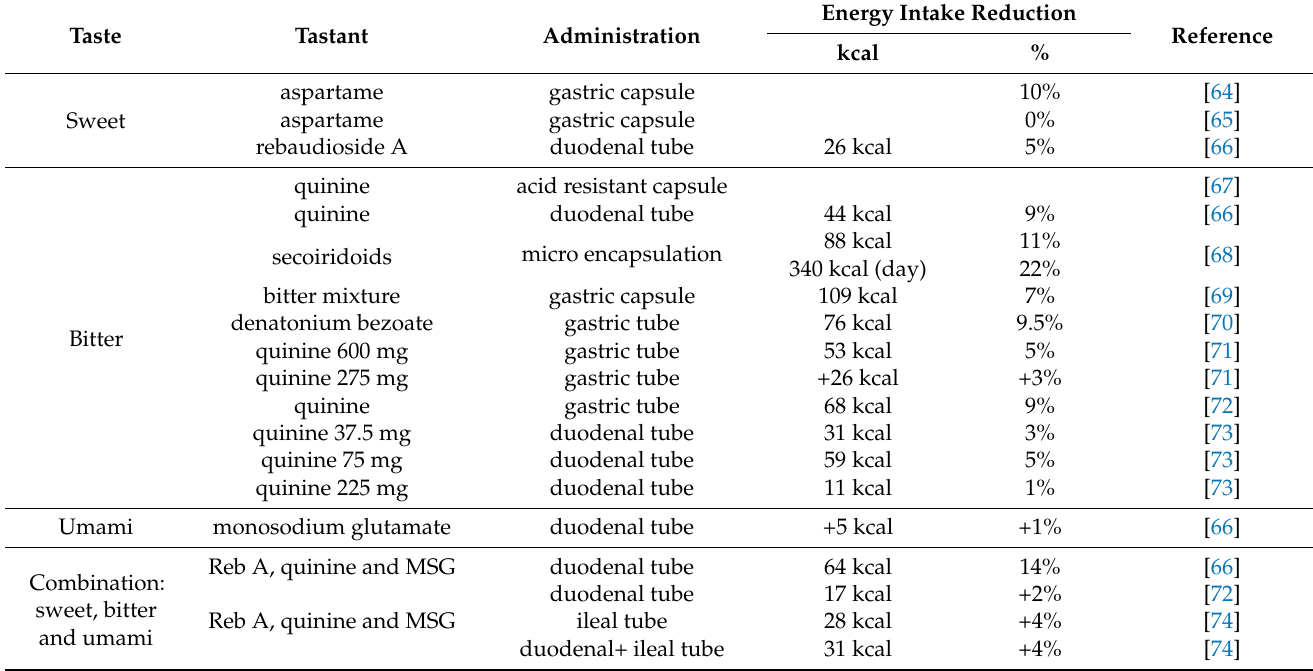
Table 7. Effect of tastants after duodenal, jejunal or ileal delivery on energy